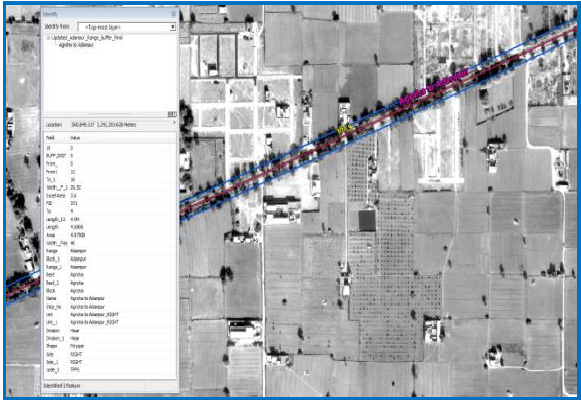
Figure 4. Vector Layer (Buffer) overlaid on WV Data (c) Analysis of Data